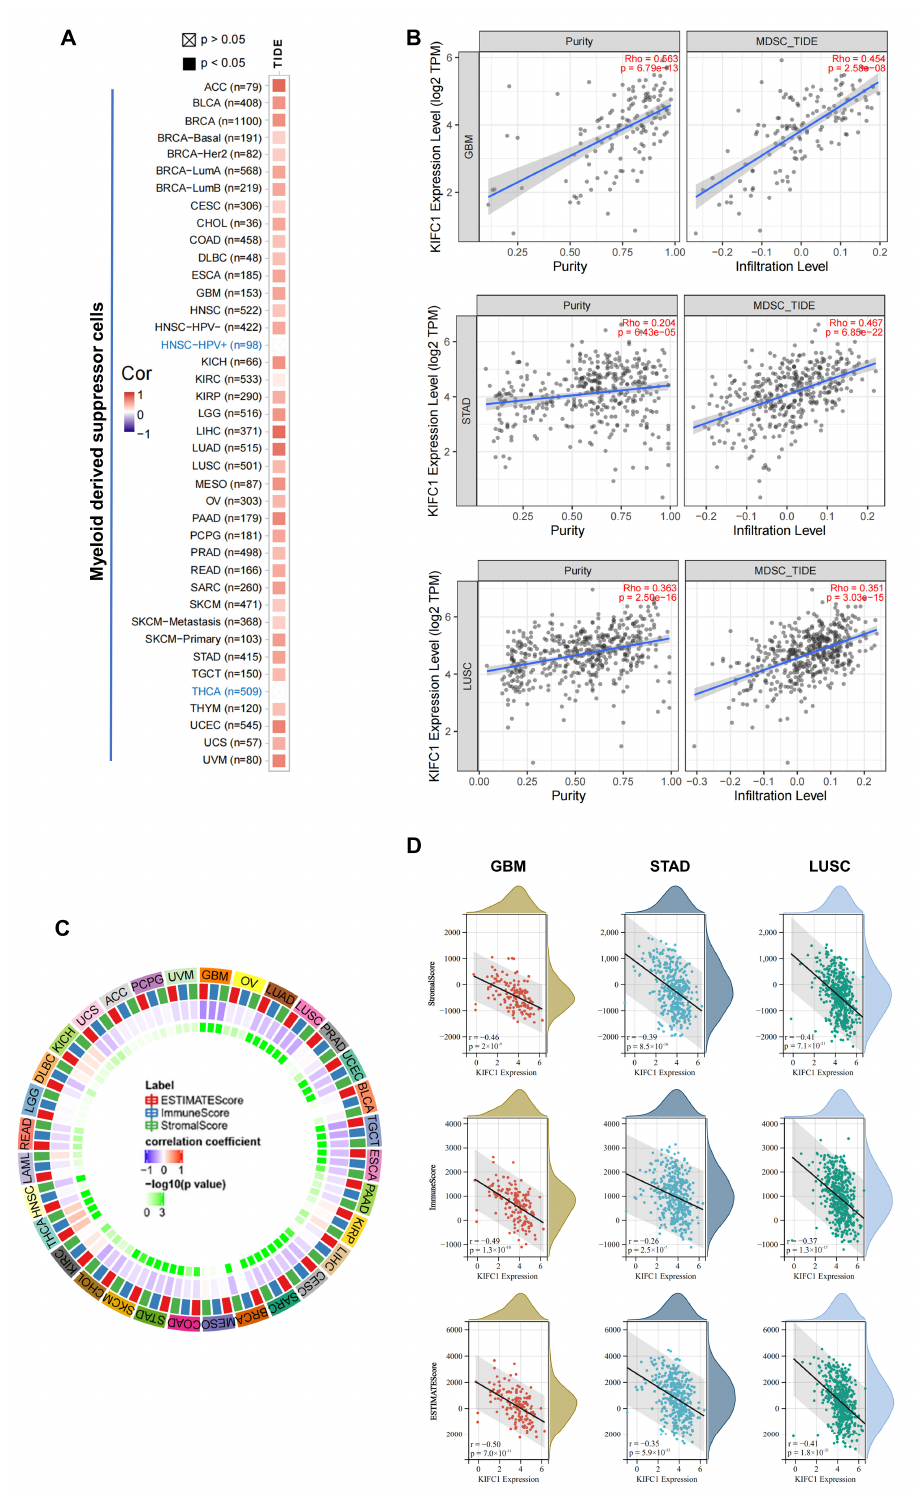
Figure 7. Immune reactivity analysis of KIFC1 in different tumors of TCGA database. ( A , B ) Correla- tion analysis of KIFC1 expression and immune infiltration of myeloid-derived suppressor cells, in purity-adjusted Spearman’s rho values, with TIDE algorithm. ( C , D ) Correlations of ImmuneScore, StromalScore, and ESTIMATEScore with KIFC1 expression in tumors, in Pearson’s correlation coeffi- cients. TIDE: tumor immune dysfunction and